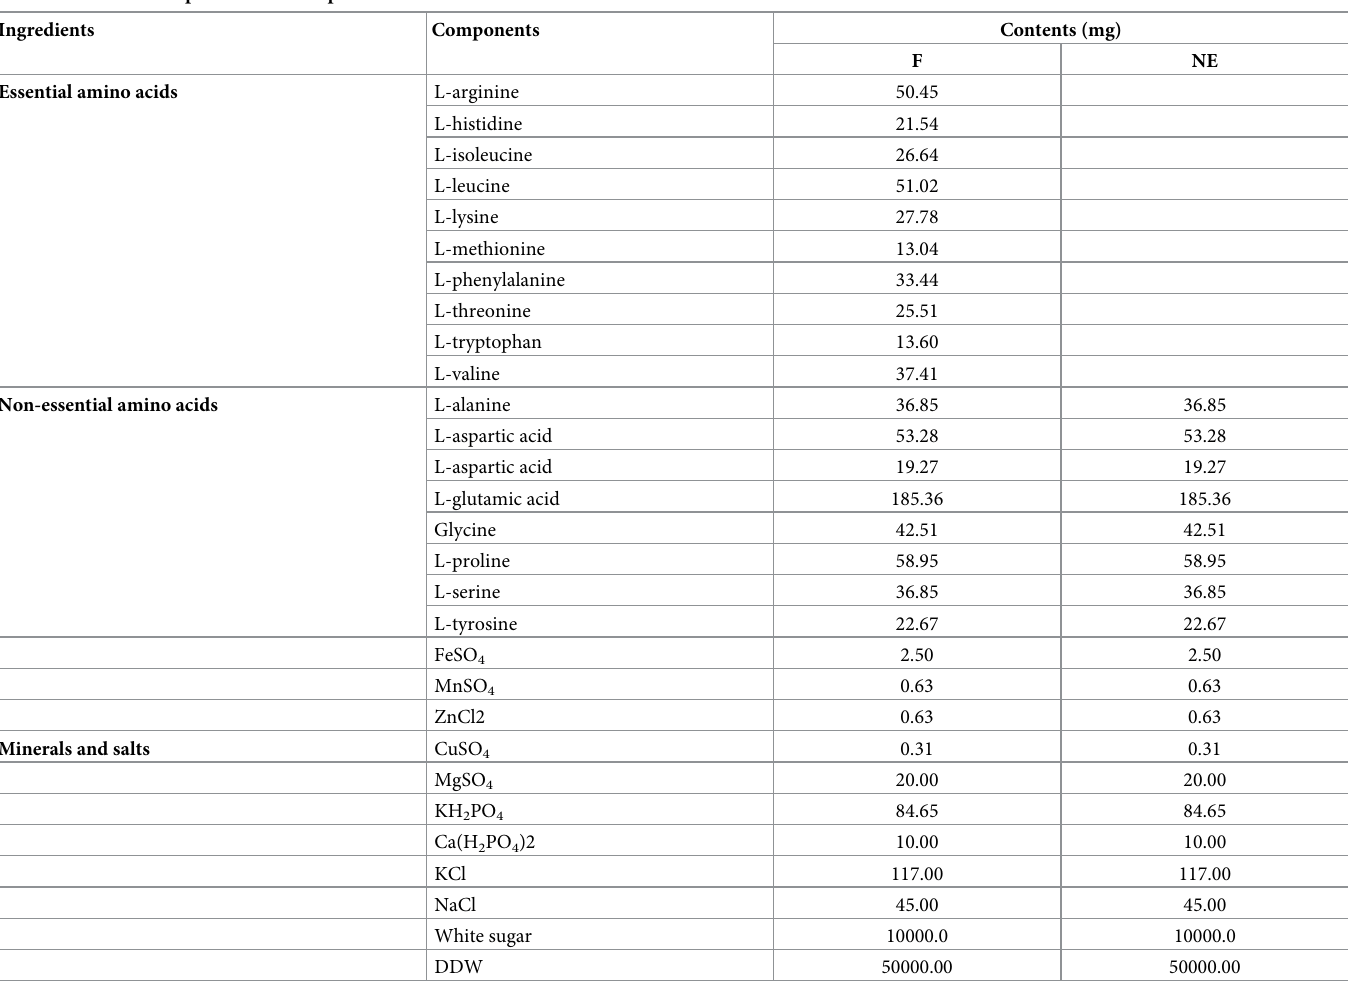
Table 2. Nutrient composition of the experimental